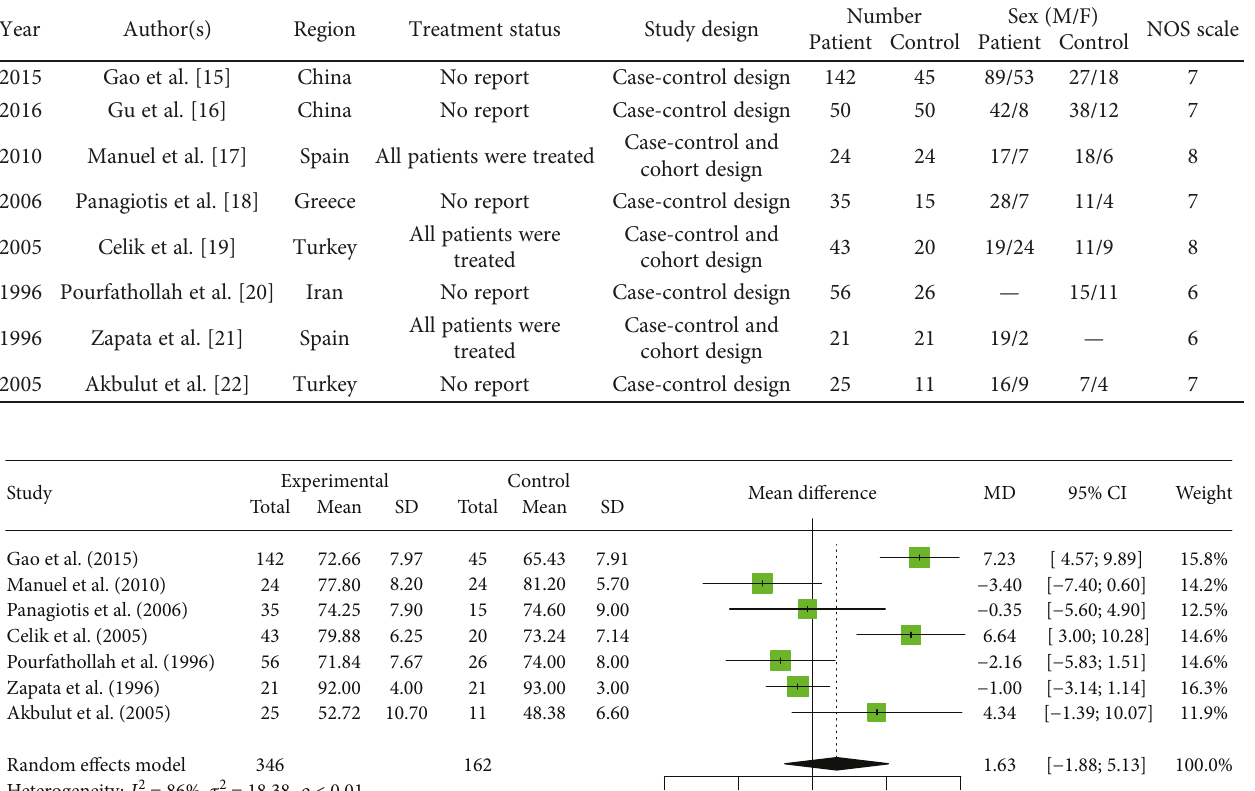
Table 1: Characteristics of studies included in the